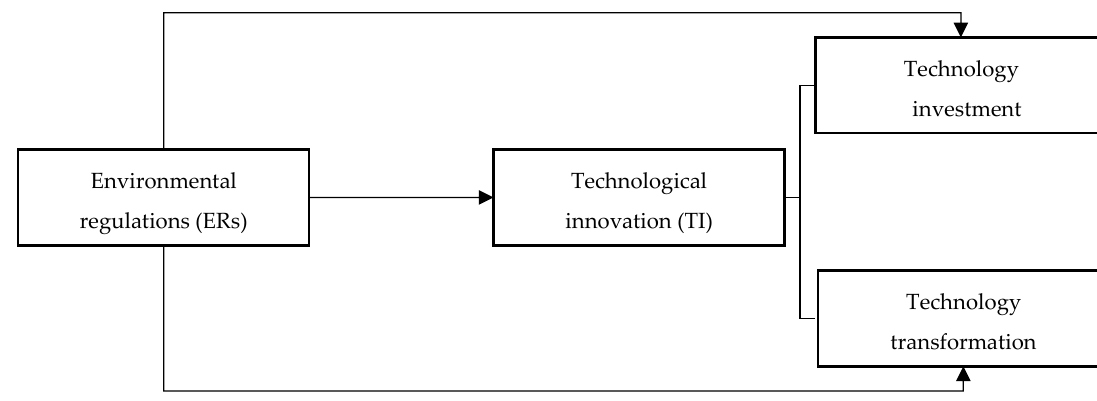
Figure 1. The conceptual framework of this study.